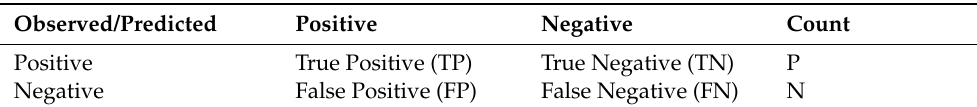
Table 3. Confusion matrix.